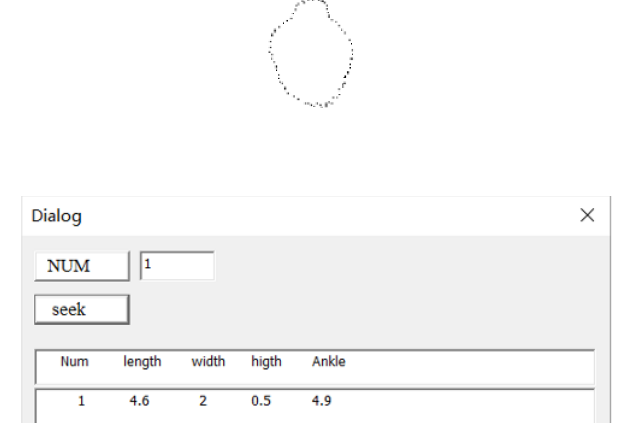
Fig. 14. Os Cuneiforme.